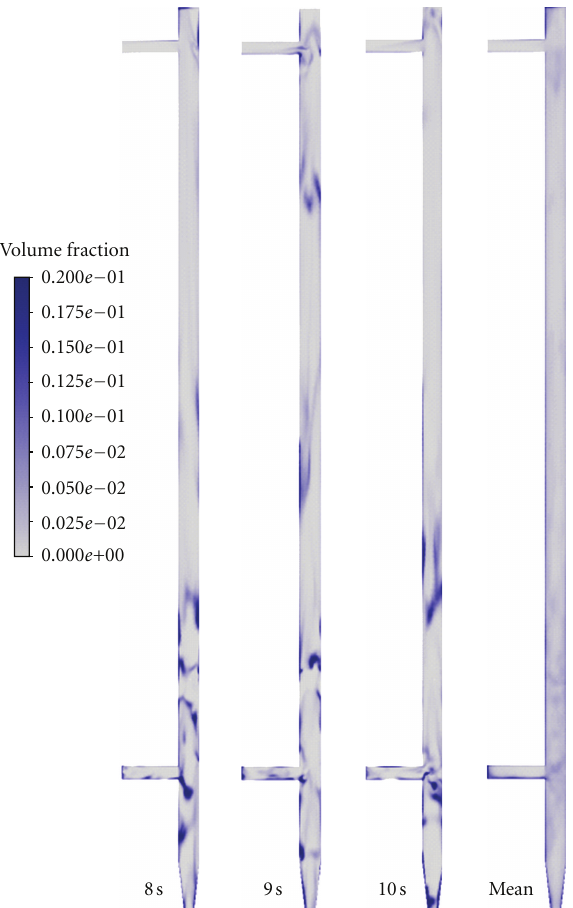
Figure 7: Instantaneous solid-phase volume fraction at 8, 9, and 10 seconds and the mean time average on an axial plane of the riser.